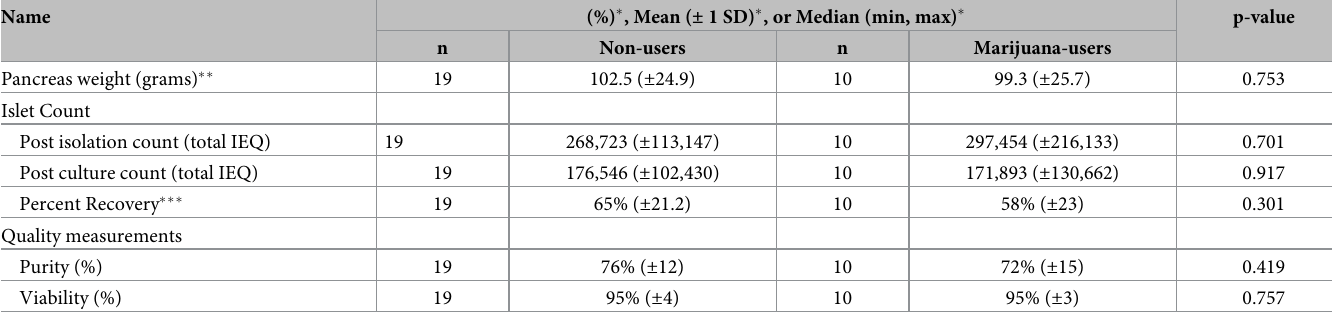
Table 2. Islet isolation assessment of pancreata from marijuana users and non-users.